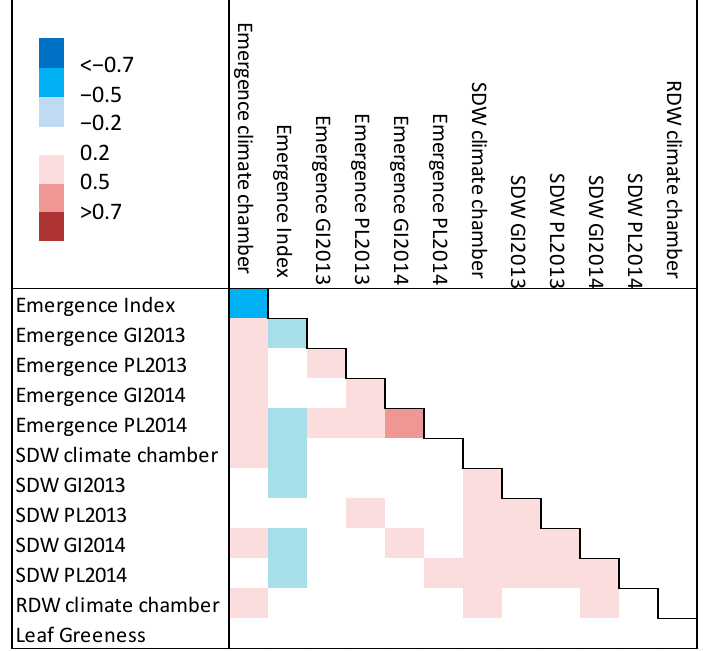
Figure 1. Heatmap showing Pearson’s correlation coefficients (r) among traits for chilling tolerance and juvenile development. All highlighted correlations are significant at 0.001 level. SDW, shoot dry weight; RDW, root dry weight; GI, Giessen; PL, Poel.